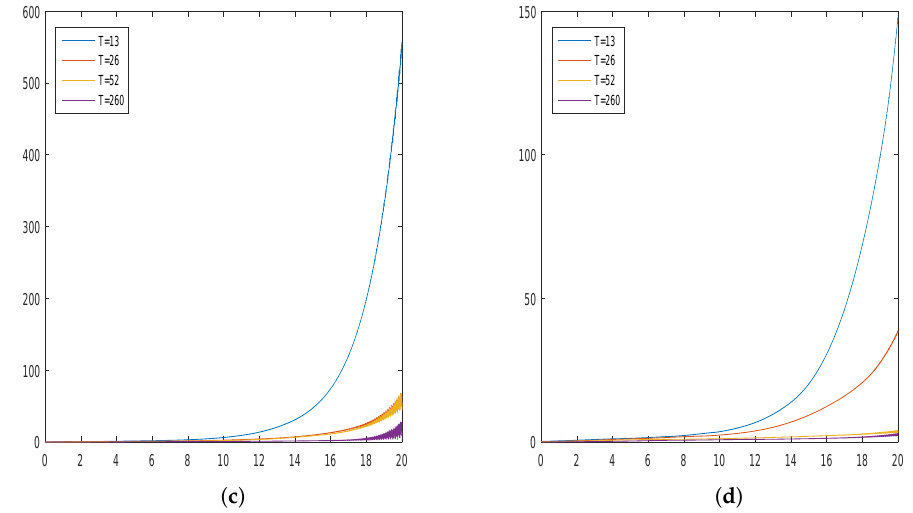
Figure 5. Estimation of the Laplace transform of ruin time for different claim sizes. Mean relative error curves: ( a ) exponential claim sizes; ( b ) Erlang claim sizes; ( c ) combined-exponential claim sizes; and ( d ) mixed-exponential claim sizes.